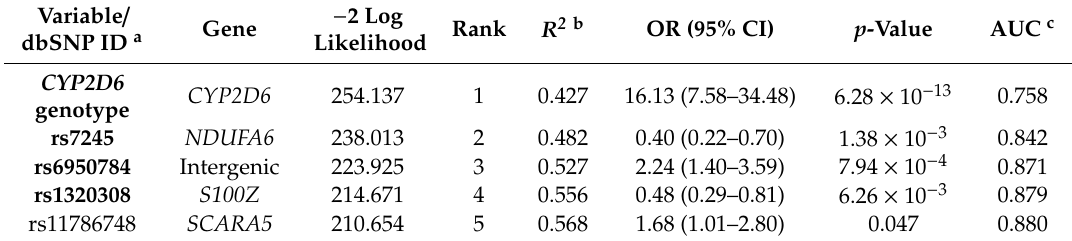
Table 3. Multivariate regression analysis considering a set of 13 SNPs and the CYP2D6 genotype (Approach 1).